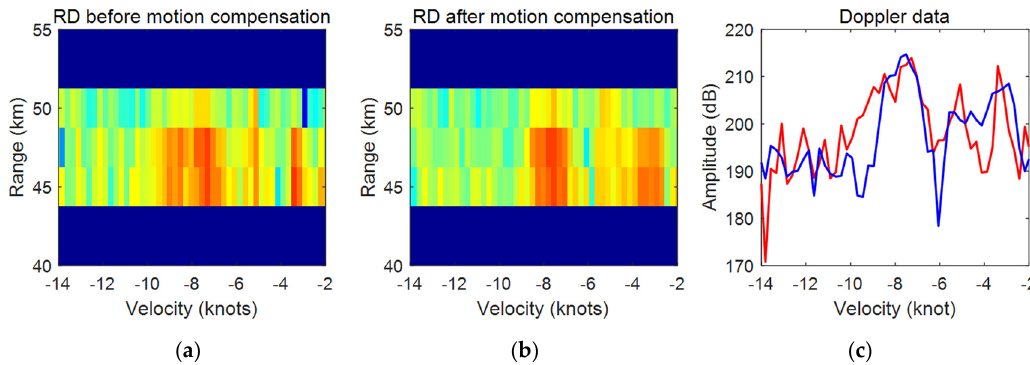
Figure 30. Target T2 Doppler spectral results before and after motion compensation during P2: ( a ) two-dimensional RD spectral results before motion compensation, ( b ) two-dimensional RD spectral results after motion compensation, and ( c ) one-dimensional spectral results before and after motion